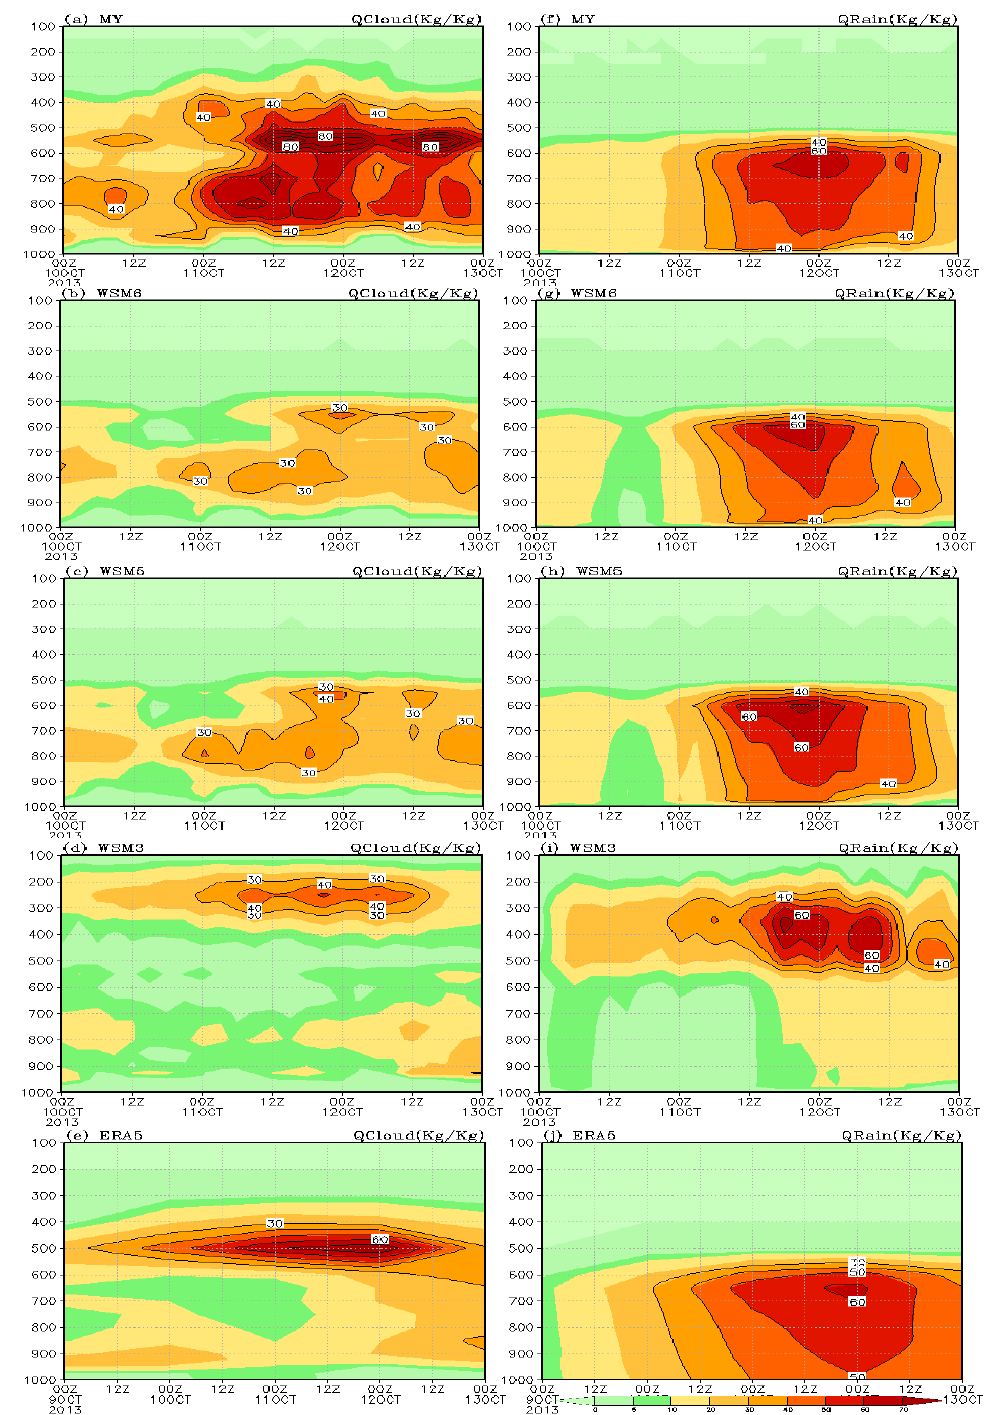
Figure 12. Time-pressure cross-section of the WRF simulations of Qcloud (×10 6 kg·kg − 1 ) derived from ( a ) MY ( b ) WSM6, ( c ) WSM5, ( d ) WSM3 schemes, and (i) ERA5 reanalysis with the averaged area over 82–92° E and 14–20° N from 00 UTC, from 10 to 13 October 2013, measured in 3-hourly intervals at D02 resolutions. Similarly, Qrain (×10 6 kg·kg − 1 ) mean mass contents are derived from ( e ) MY, ( f ) WSM6, ( g ) WSM5, and ( h ) WSM3 schemes, and ( j ) observation respectively.